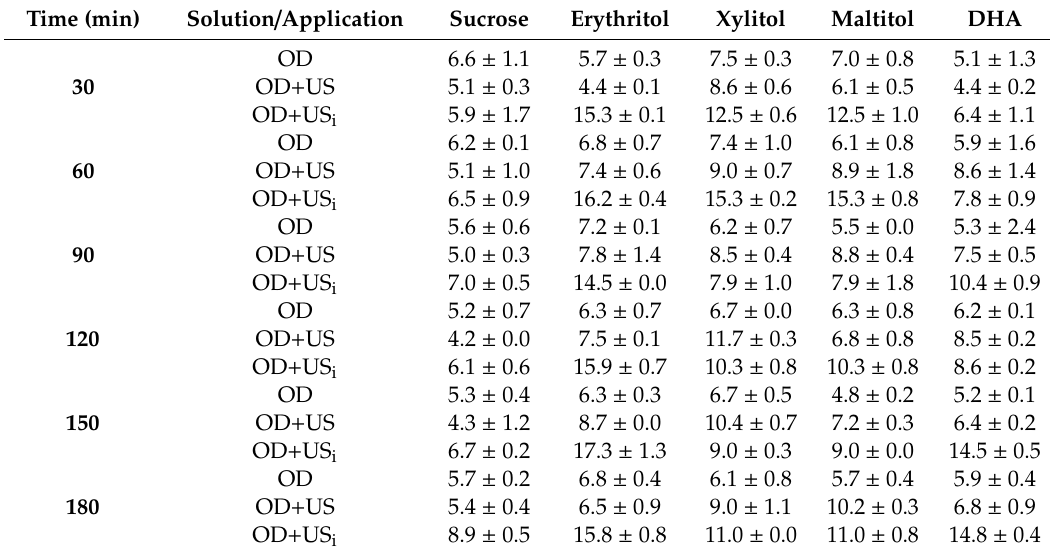
Table 14. Values of absolute colour di ff erence ( ∆ E) during OD in di ff erent solutions. OD: osmotic dehydration; US: continuous sonication; USi: interval sonication.